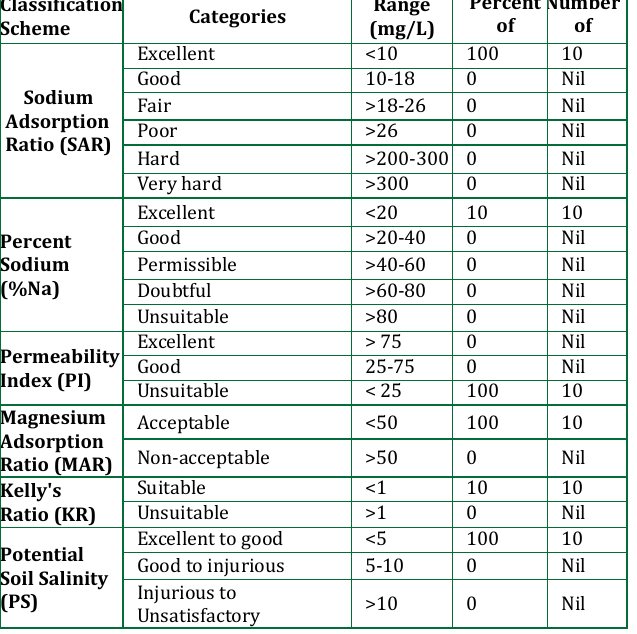
Figure 3: Groundwater classification for irrigation purposes based on Wilcox (1955) diagram 3. C ONCLUSION This study revealed that the value of Na% ranges from 1.44 to 5.78 in Khana and 9.69 to 29.29 in Gokana area. These results show that the water